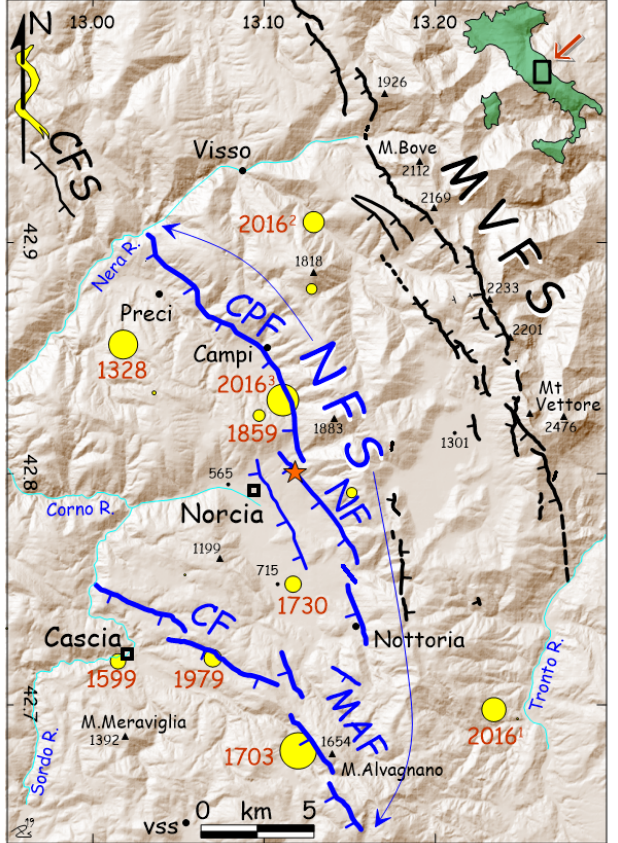
Figure 1. Shaded relief map of the region traversed by the Norcia fault system (blue lines, NFS. CPF, Campi-Preci faults; NF, Norcia fault; MAF, Mount Alvagnano faults; CF, Cascia faults) and by the Mount Vettore (black lines, MVFS). CFS, southern tip of the Colfiorito fault system. Yellow circles, epicenters of Mw ≥ 5.5 (modified from [23]). MVFS was responsible for the three mainshocks of the 2016 seismic sequence, labelled 2016 1 − 3 . Orange star indicates the limekiln location.